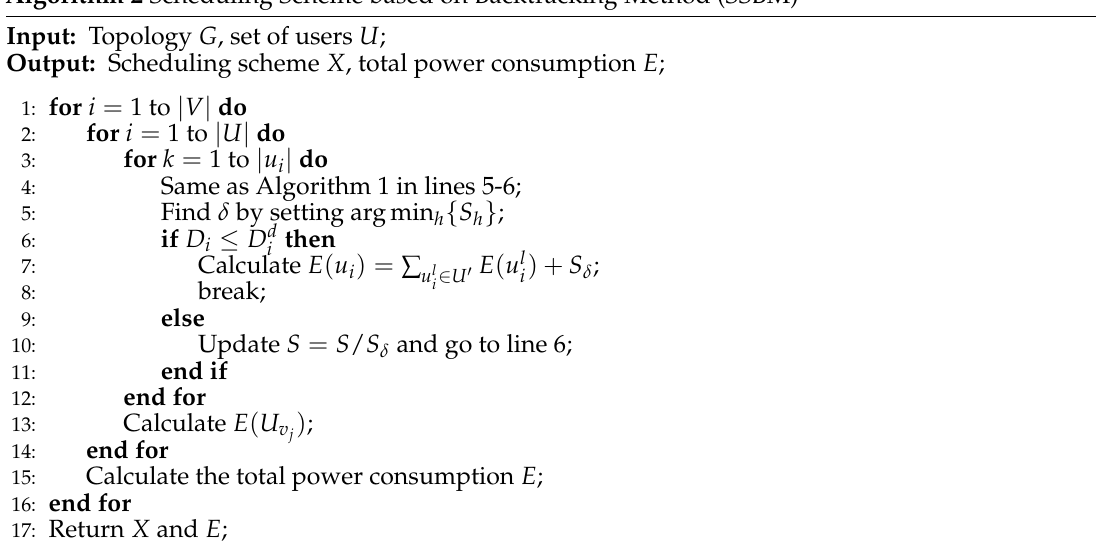
Algorithm 2 Scheduling Scheme based on Backtracking Method